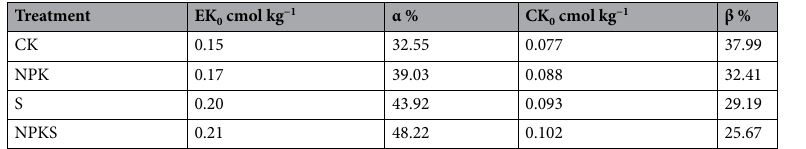
Table 5. Effect of long-term straw return on the equilibrium exchangeable K (EK 0 ), equilibrium solution K (CK